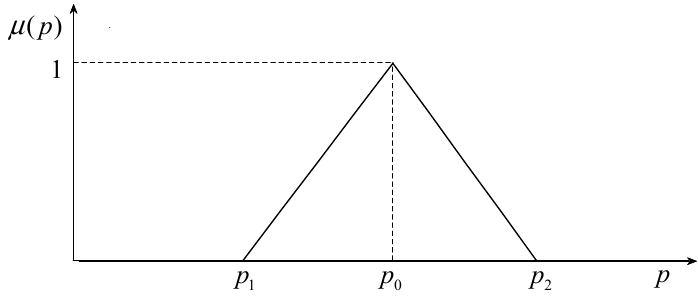
Figure 3. Membership function of triangular fuzzy number.